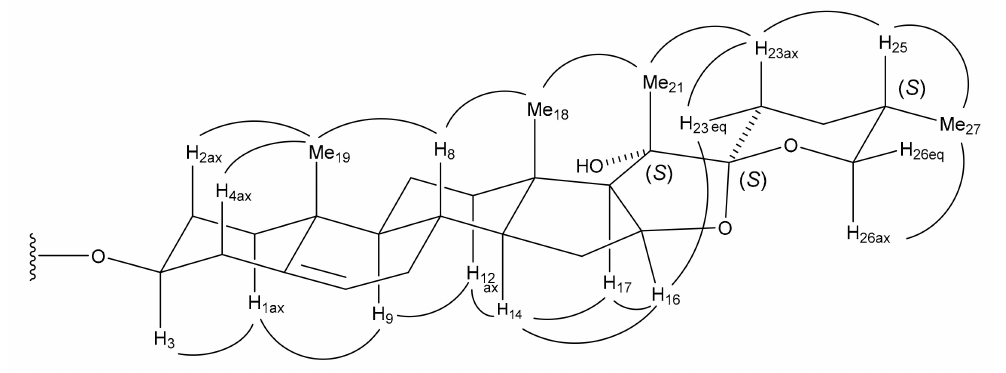
Figure 3. Key Nuclear Overhauser effect (NOE) correlations of 13a